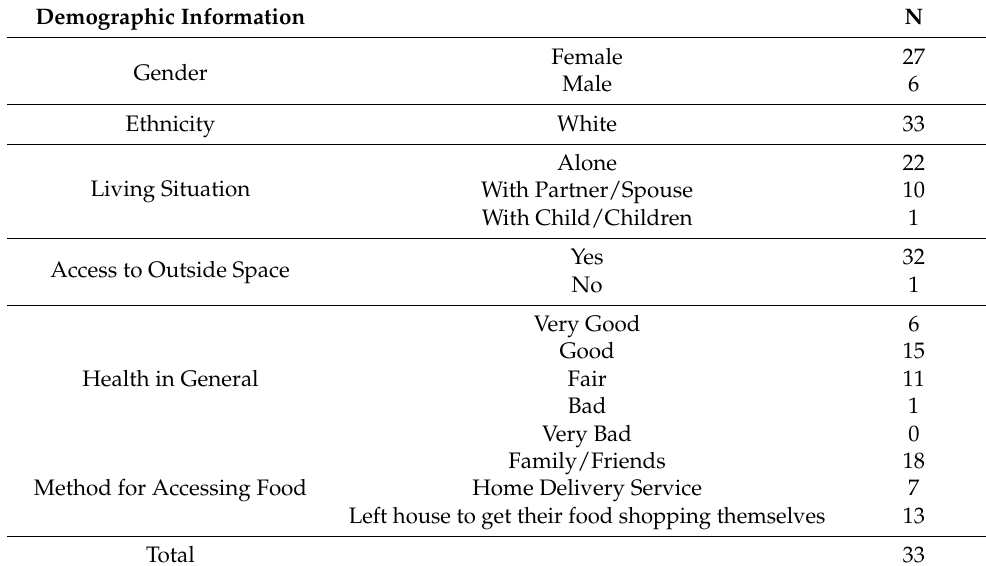
Table 1. Summary of Demographic Data for